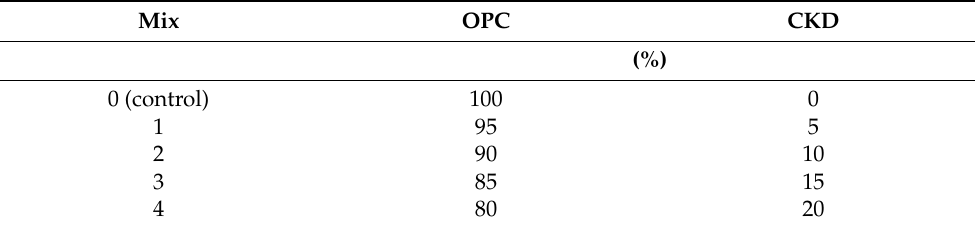
Table 4. Relative contribution of ordinary Portland cement (OPC) cement kiln dust (CKD) to test mixtures.